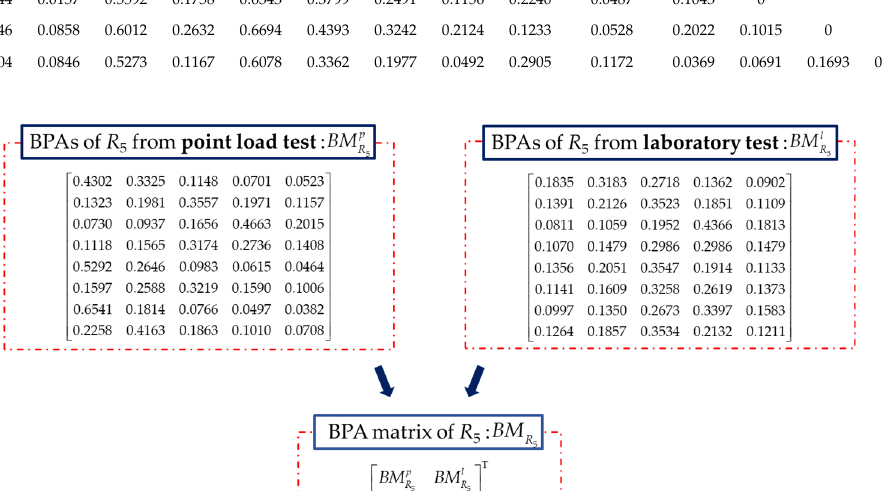
Equation (28). The initial fusion of R 5 for the proposed method is done and the result is shown in Figure 8e, which indicates the quality of the rock intact rock alterability in this section is in level III with the maximum probability of 0.9558.